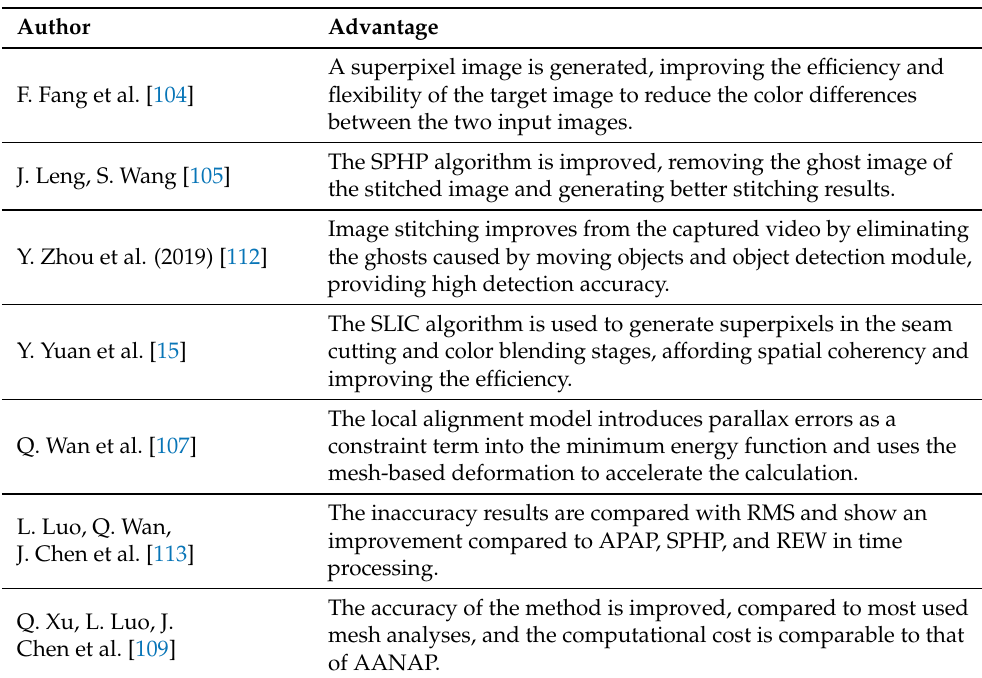
Table 8. Mesh-based methods applied on